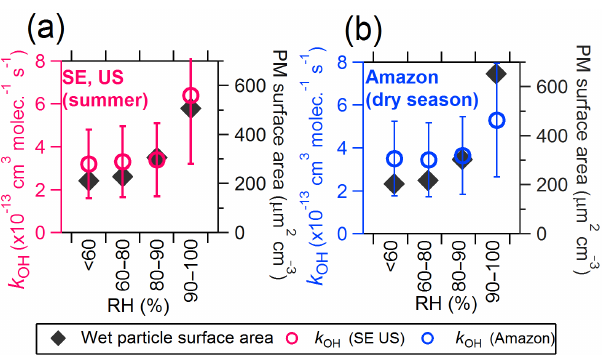
Figure 7. Estimated k OH of IEPOX-SOA vs. ambient RH during the SE US and Amazon studies. The ambient wet particle surface areas in both studies are shown on the right